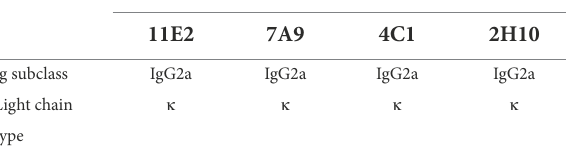
TABLE 1 Identification of the subclasses of CD2v monoclonal